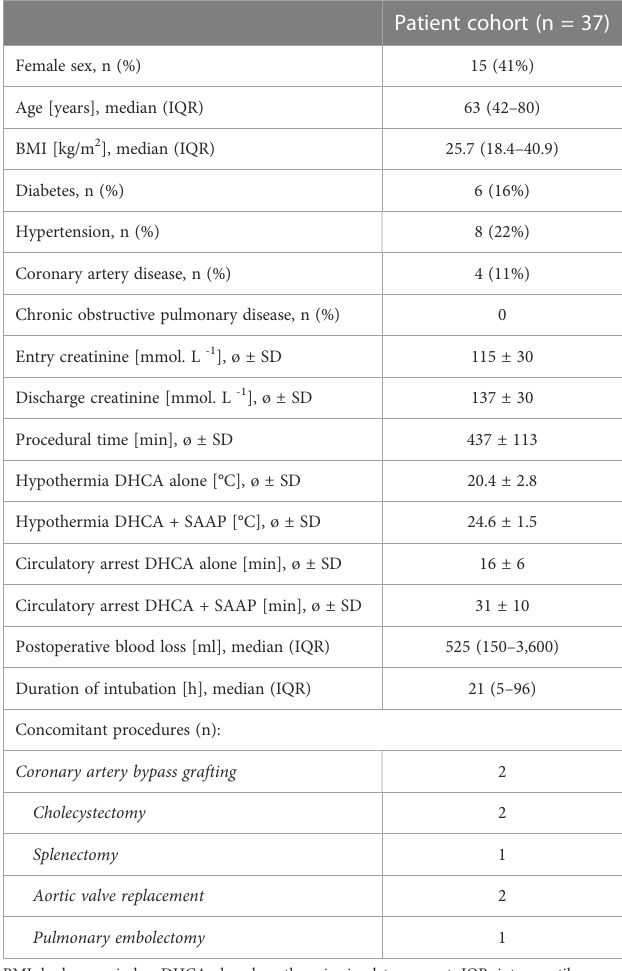
TABLE 1 The patient demographic characteristics and perioperative